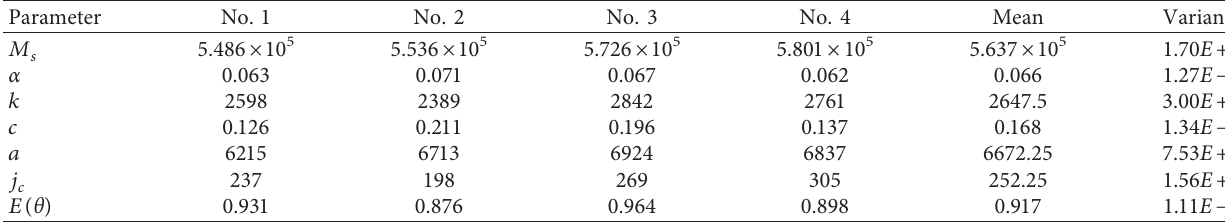
Table 3: Repeated identified data of DEA.